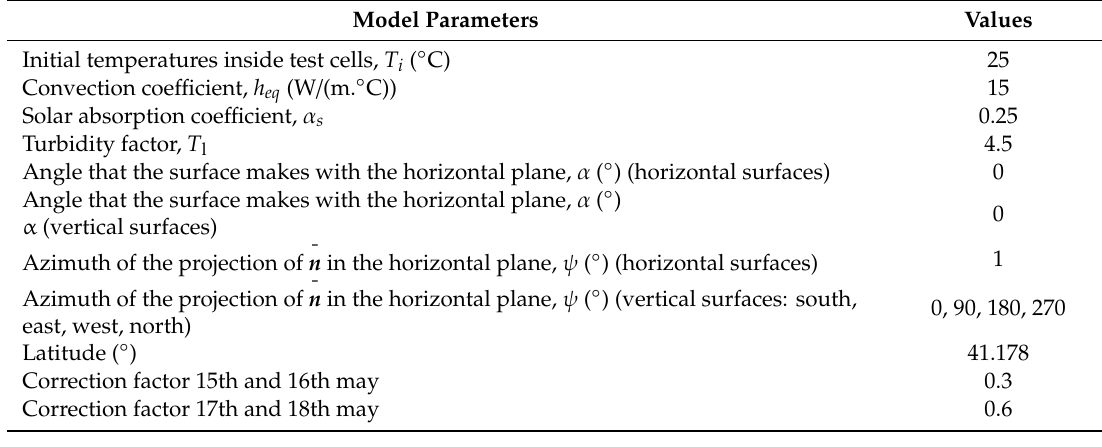
Table 2. Model parameters and operation